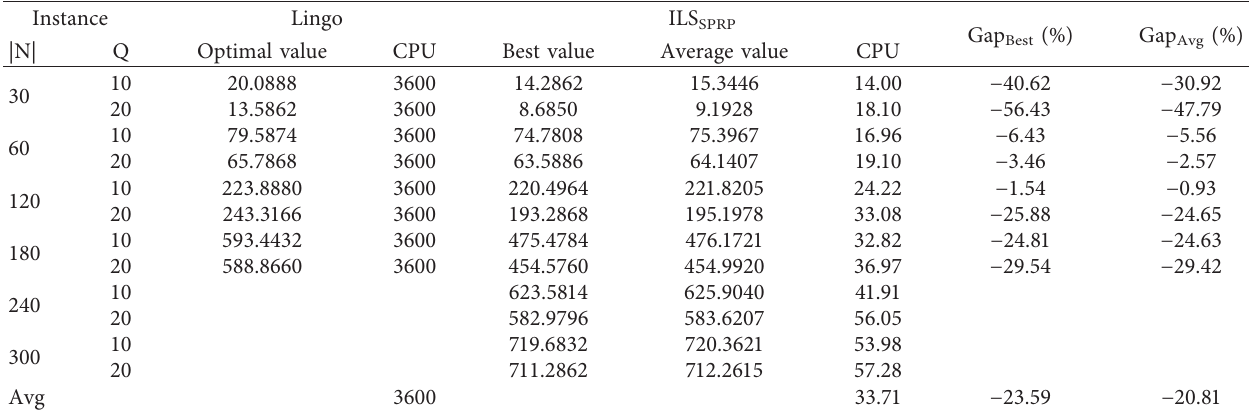
Table 5: Result comparison of Lingo and ILSSPRP ( T � 28800s).